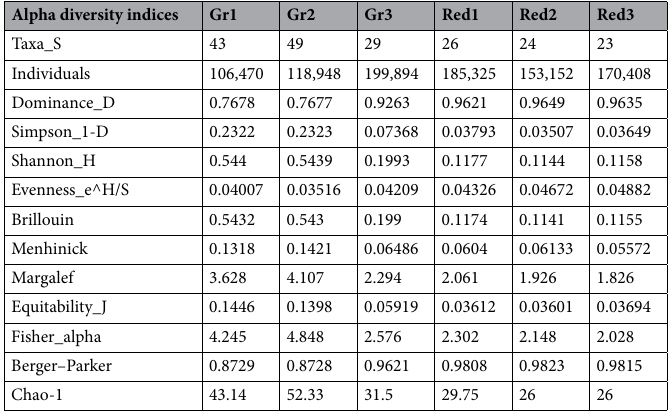
Table 3. Characteristics of sponge microbiome alpha diversity and richness.